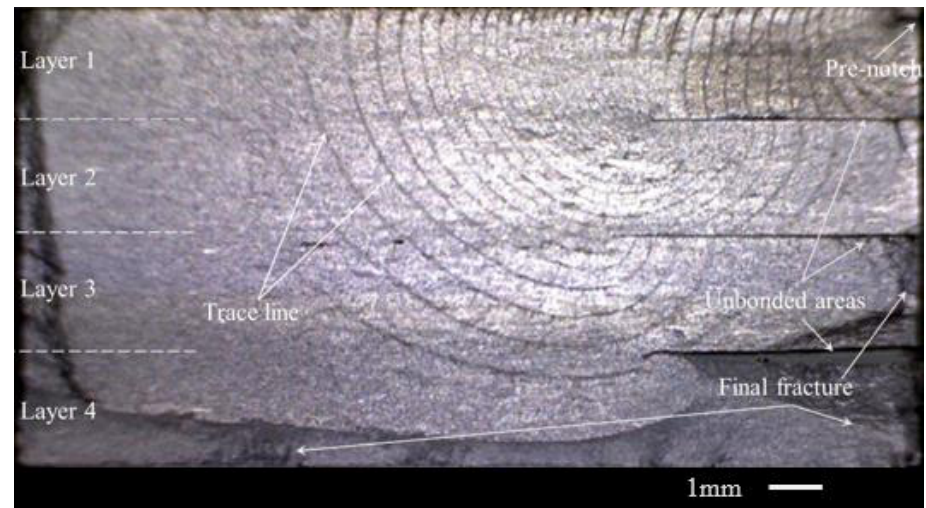
Figure 6. The base information of the fracture surface of Specimen B-1 in Group B.